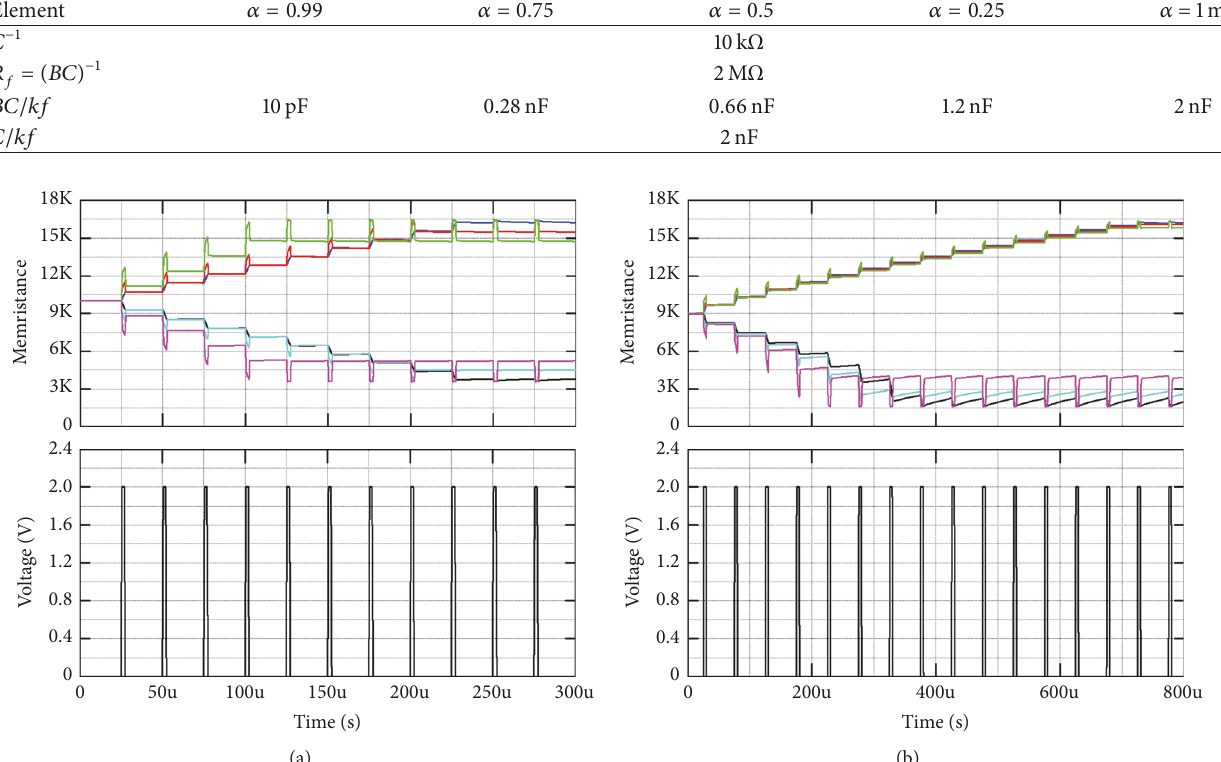
Table 3: Component list of Figure 1 when 𝛼 varies, assuming 𝐶 = 0.1 mF and 𝑘𝑓 = 50 e3.